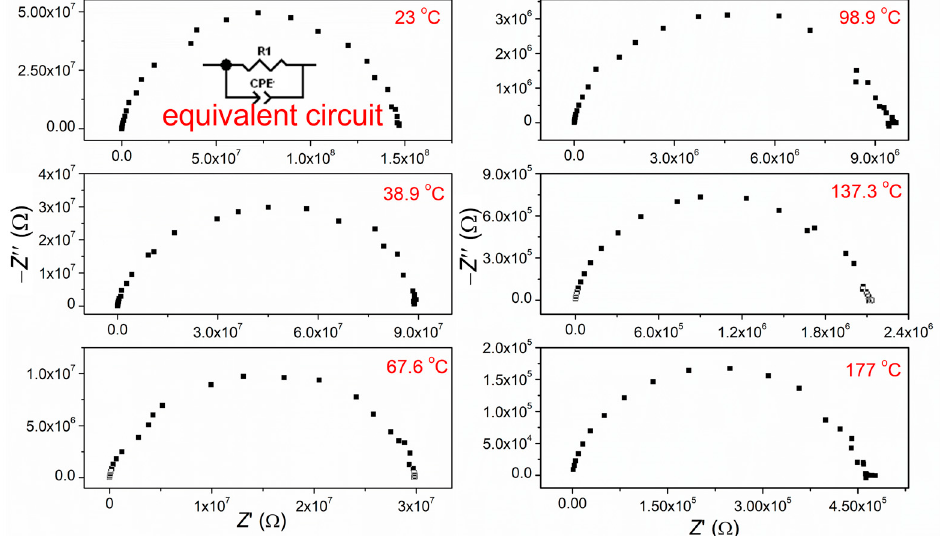
Figure 7. Complex impedance spectra for CCTO ceramics at selected temperature; as an inset: scheme of an equivalent circuit model used for fitting impedance spectra of CCTO ceramic.